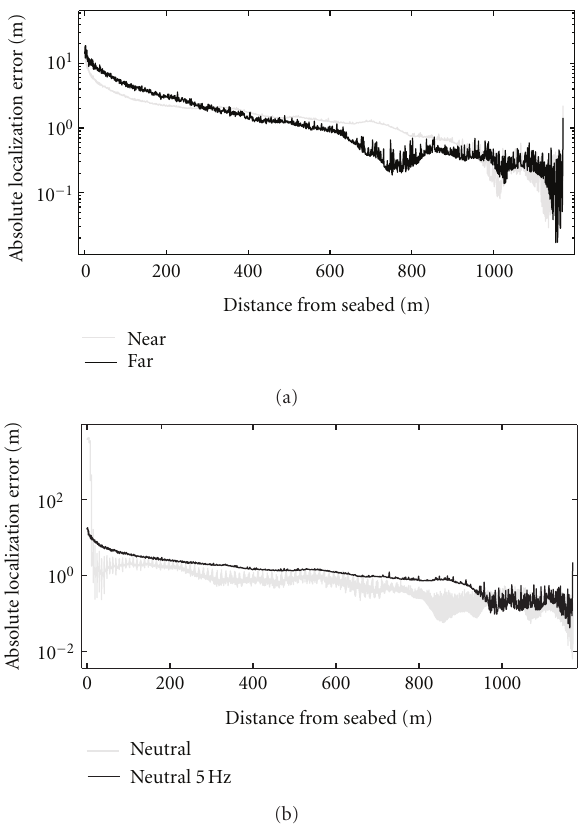
Figure 13: Total localization error (in global coordinates) as a function of distance from the seabed, for neutral, near and far configurations with the mesh of 1.680 points (1.44Hz). The neutral configuration error for the mesh with 7.630 points (5Hz) is also